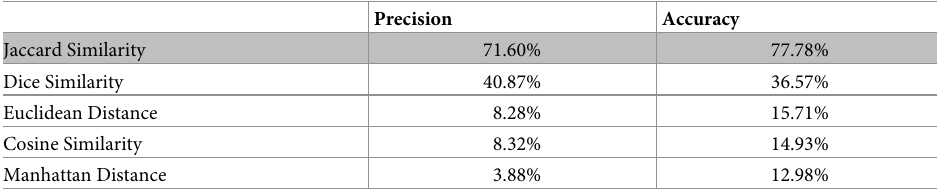
Table 8. Comparison of dataset with different similarity/distance